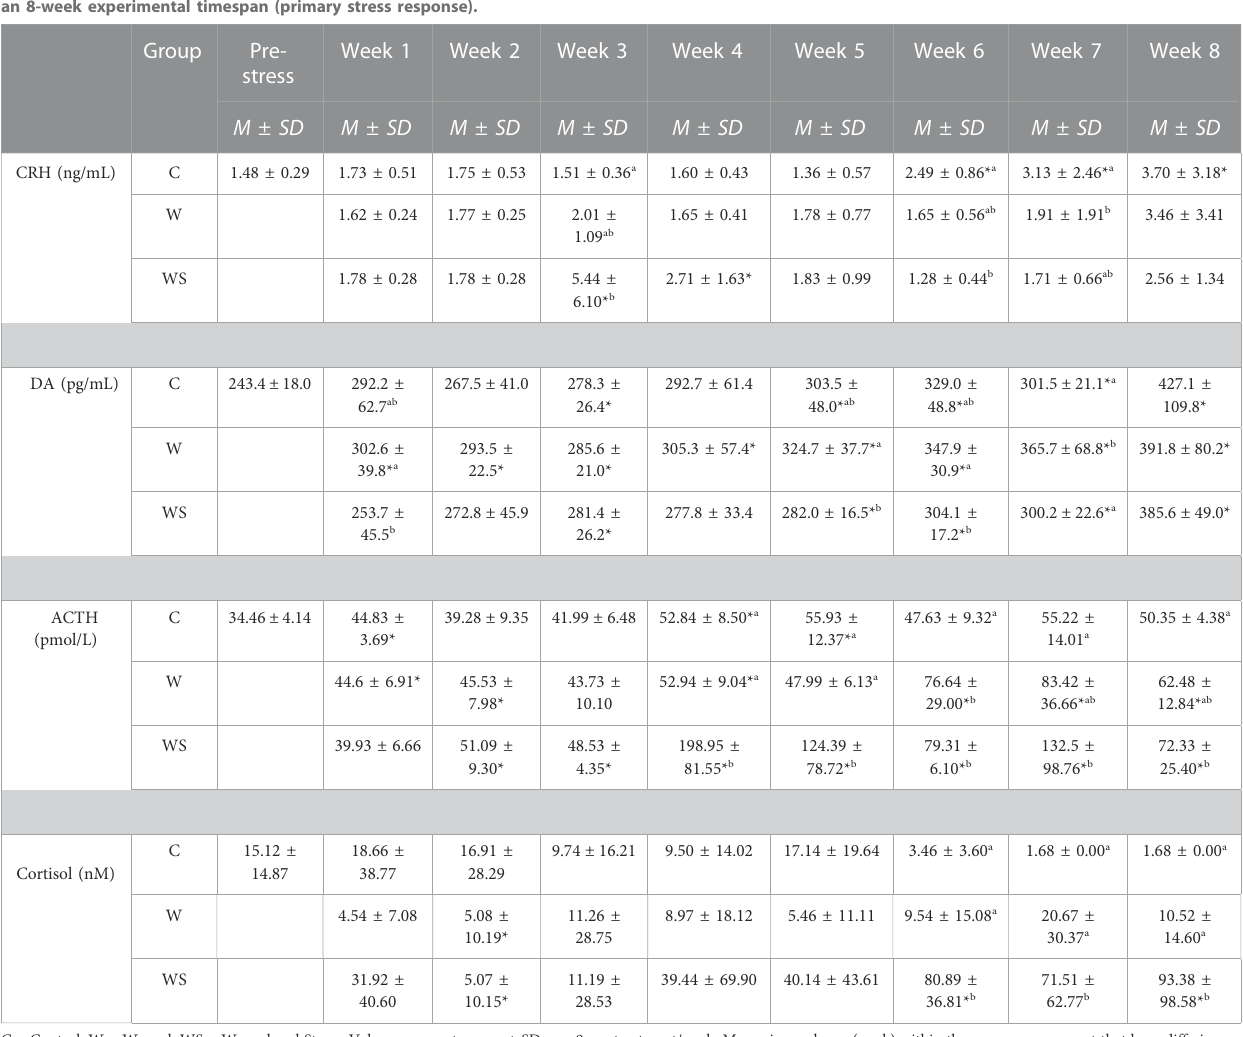
TABLE1Mean±SD(n=9)forCRH(ng/mL),Dopamine(DA)(pg/mL),ACTH(pmol/L)andcortisol(nmol/L)incontrol(C),wound(W)andwound+stress(WS)during an 8-week experimental timespan (primary stress